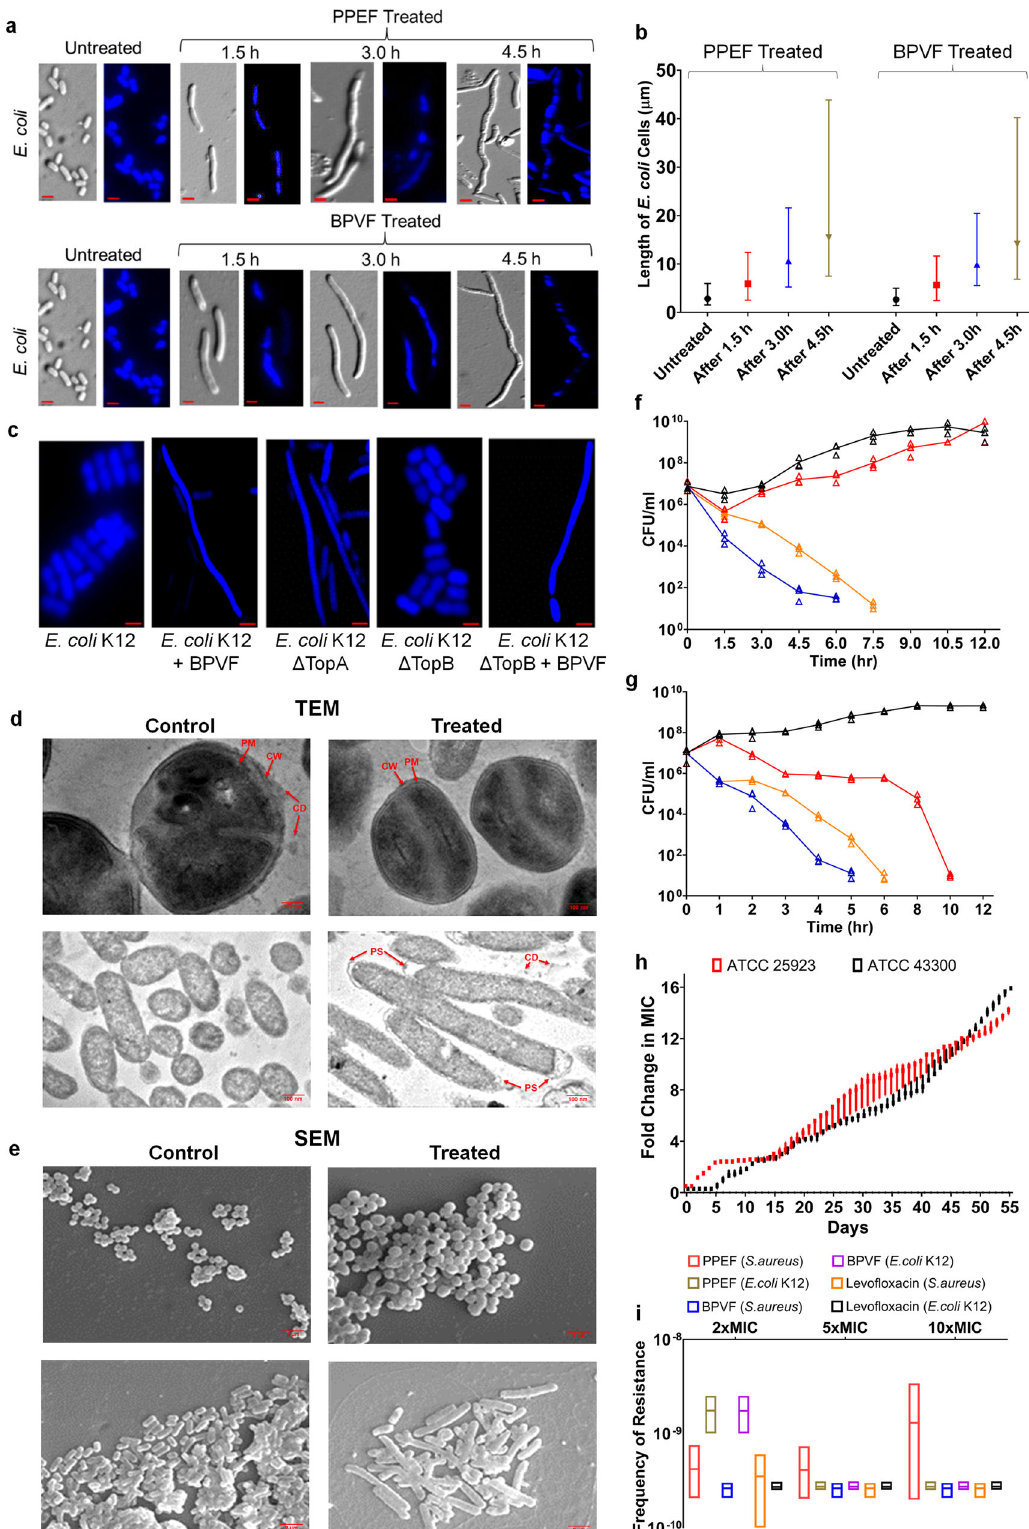
infection occurred at 10 mg/kg bw and 4 log fold at 20 mg/kg bw dose of PPEF and levo fl oxacin (Fig. 6j). In the neutropenic thigh VRSA (S1016) infection mice model, ~2 log fold decrease in infec- tion occurred at 10 mg/kg bw and 4 log fold at 20 mg/kg bw dose of BPVF and CIP (Fig. 6k).The 1, 2.2, and 4 Log CFU/g reduction of